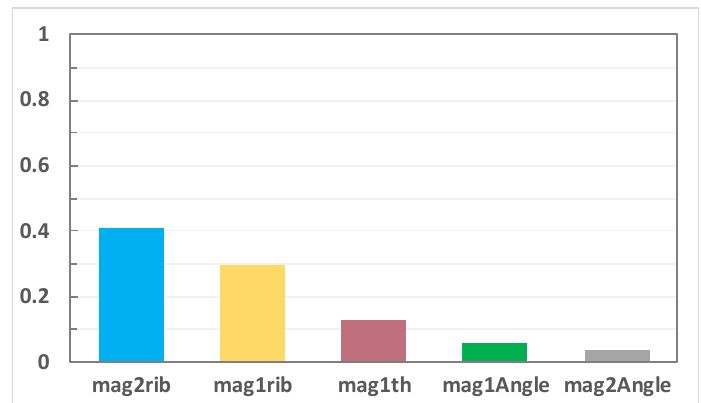
Figure 12. 48th electromagnetic force-optimal factor contribution.